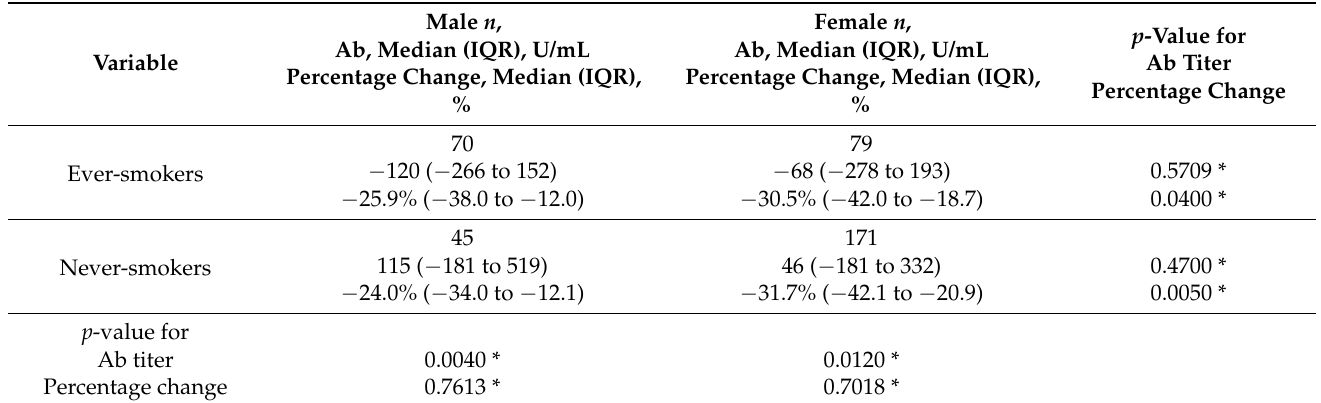
Table 4. Age-adjusted median Ab titers and percentage changes in the relationship between sex and smoking.